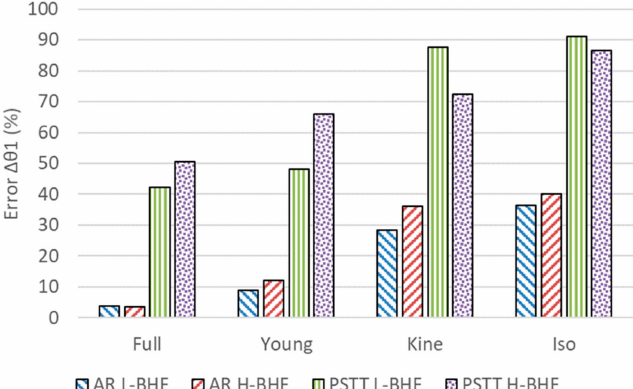
Figure 14. Accuracy of the di ff erent models in terms of the ∆ θ 1 springback angle.